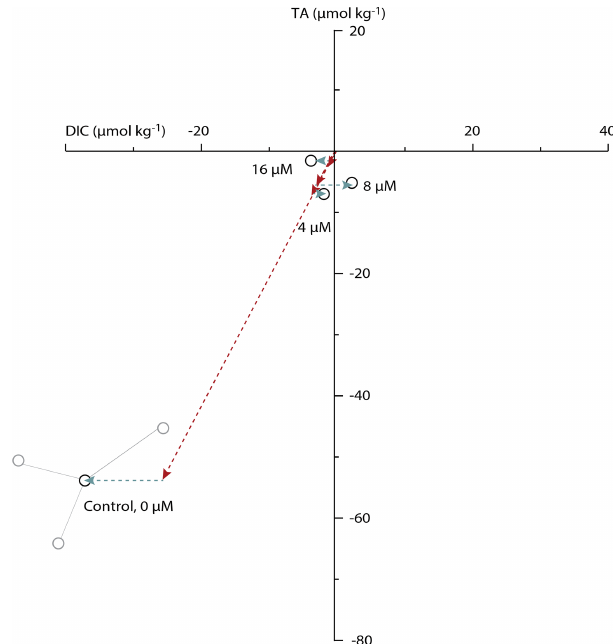
Figure 3. Changes in total alkalinity versus DIC for all concen- trations of acetazolamide (AZ) used. Every black circle represents the average change in DIC– T A for one triplicate of incubations. The three gray circles show the measured DIC– T A combination for each of the triplicate measurements within the control treat- ment. For the three additions of AZ, replicates never differed more than 8µmolkg − 1 from the average for DIC and never more than 5µmolkg − 1 from the average for T A . Arrows show the calcifica- tion (red) and net respiration (blue) effects.